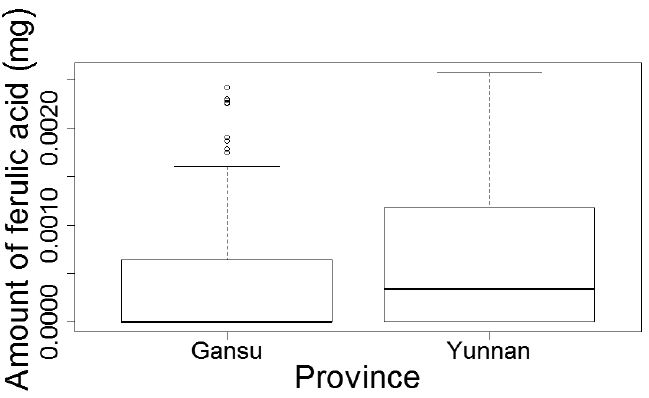
Figure 3. Amounts of ferulic acid of whole roots compared between Gansu and Yunnan Province. Error bars represent the 95% confidential intervals (Gansu, n = 111; Yunnan, n = 93).